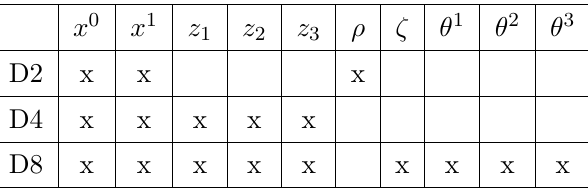
-BPS brane intersection underlying the geometry (5.2)–(5.4). ( x 0 , x 1 ) are the Table 8 . 1 8